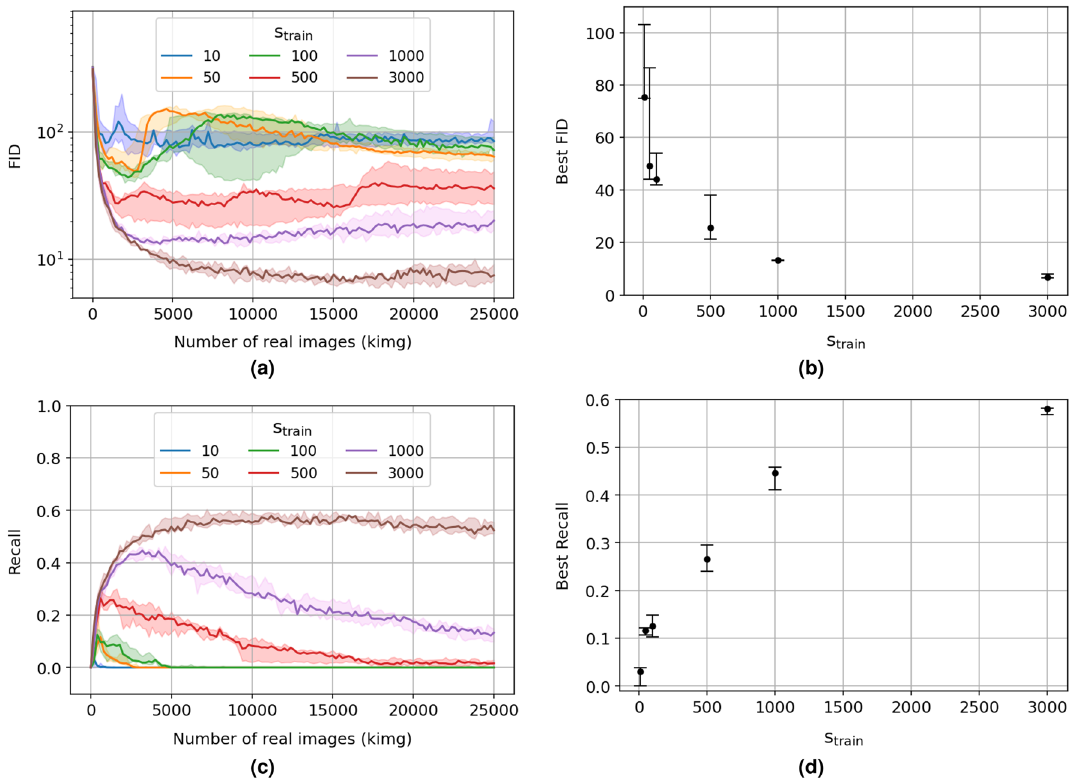
Figure 3. ( a , c ) Fréchet inception distance 36 (FID, lower is better) and recall 37 (higher is better) on generated SEM images as a function of the number of real images (per thousand images, kimg) presented to the discriminator during training of the StyleGAN2 8 for different sizes of the training set: 10 (blue), 50 (orange), 100 (green), 500 (red), 1000 (violet), and all (brown) 3000 SEM images; ( b , d ) Corresponding median (black dot), minimum (lower cap), and maximum (higher cap) values for the best FID and recall are shown for the different sizes of the training